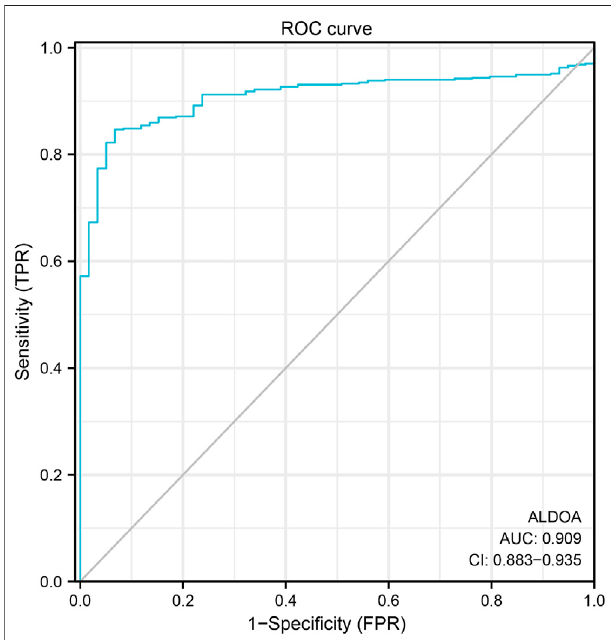
FIGURE 4 | ROC curve for distinguishing lung adenocarcinoma tissues from normal tissues. With a cutoff of 8.598, ALDOA had a sensitivity, speci fi city, and accuracy of 84.7, 93.2, and 85.5%,